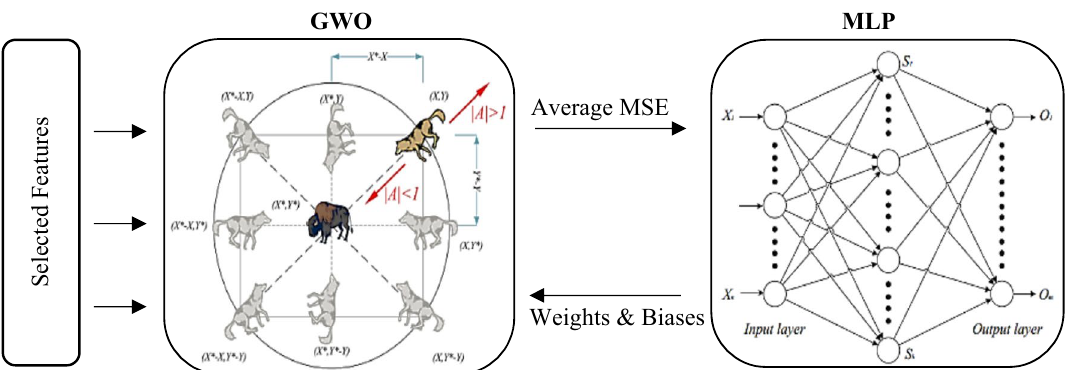
Fig. 3 MLP training with